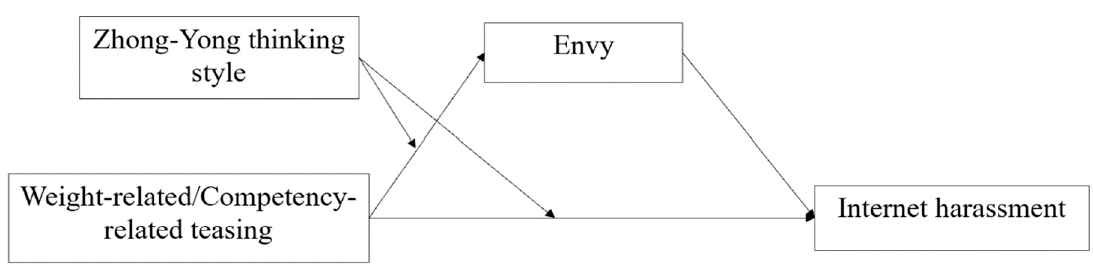
Figure 1. The proposed moderated mediation model.